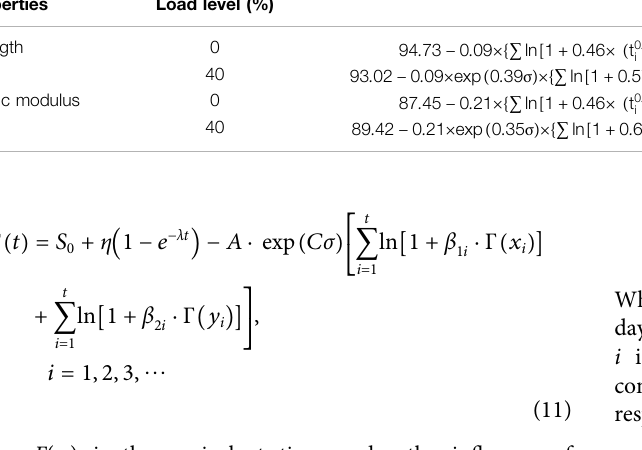
TABLE 5 | Predictive equations for tensile properties under combined hygrothermal conditions based on Eq. 11 .